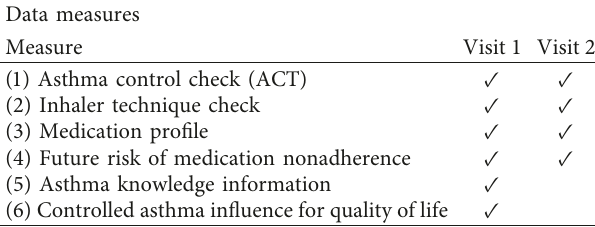
Table 3: Subject content of patient’s pharmacy